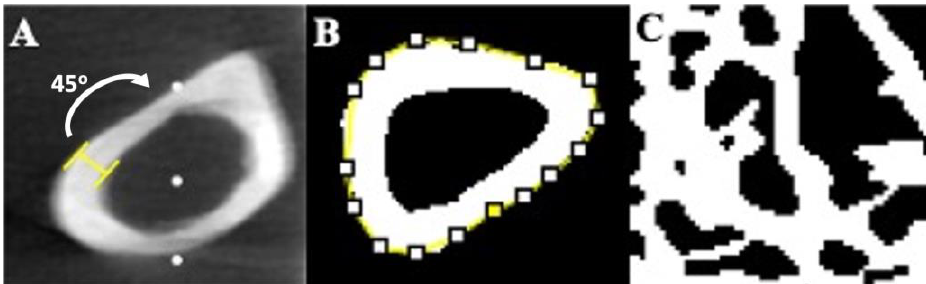
Figure 2. Representative micro-computed tomography images of femur and L5 centrum. ( A ) Femur Ct.Th measured at the mid-diaphysis as the distance between periosteal (outer) and endosteal (inner) bone surfaces using unaltered images. ( B ) Femur Ct.Ar/Tt.Ar values were obtained by making the image binary, where all bone material is made white and non-bone material is made black. An ROI (yellow) is then placed around the periosteum and Ct.Ar/Tt.Ar is measured as the fraction of white pixel to black pixel. This is repeated for every cross-sectional image within the mid-diaphysis region. ( C ) All trabecular bone measurements (BV/TV, Conn.D, Tb.Th, Tb.Sp) were obtained by isolating a square ROI containing only cancellous bone within the L5 centrum and making the image binary.